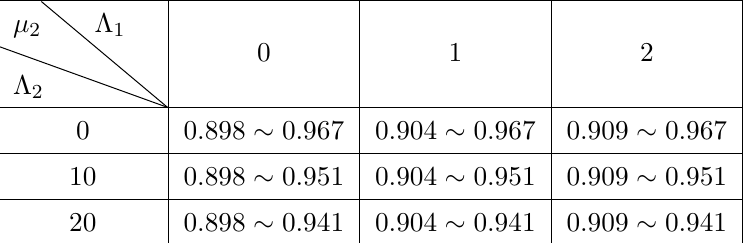
Table 6 . The domain of existence of the mass µ 2 of the scalar field φ 2 for different values of Λ 1 and Λ 2 . All solutions have µ 1 = 1 , m 1 = 1 and m 2 = 1